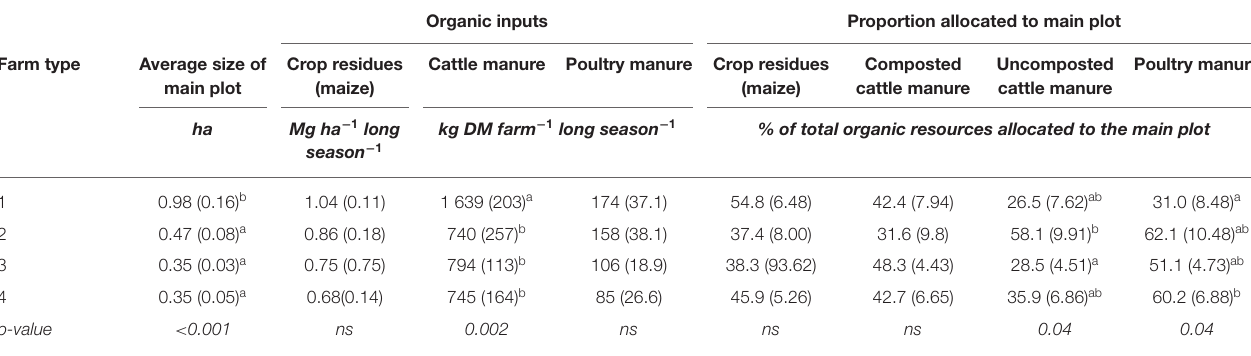
TABLE 10 | Mean total organic inputs by farm type produced by farming households ( n = 184) during a typical long rainy season in western Kenya. Organic inputs Proportion allocated to main